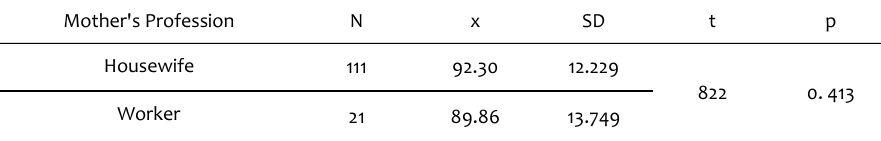
Table 4. Students' reading motivation scores in relation to mother profession